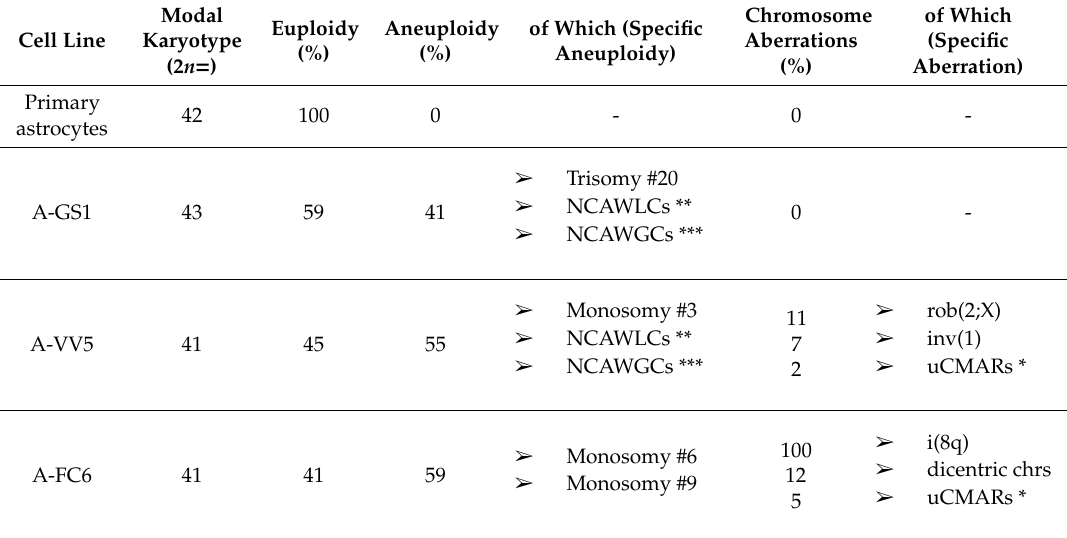
Table 1. Cytogenetic results found in the four cell